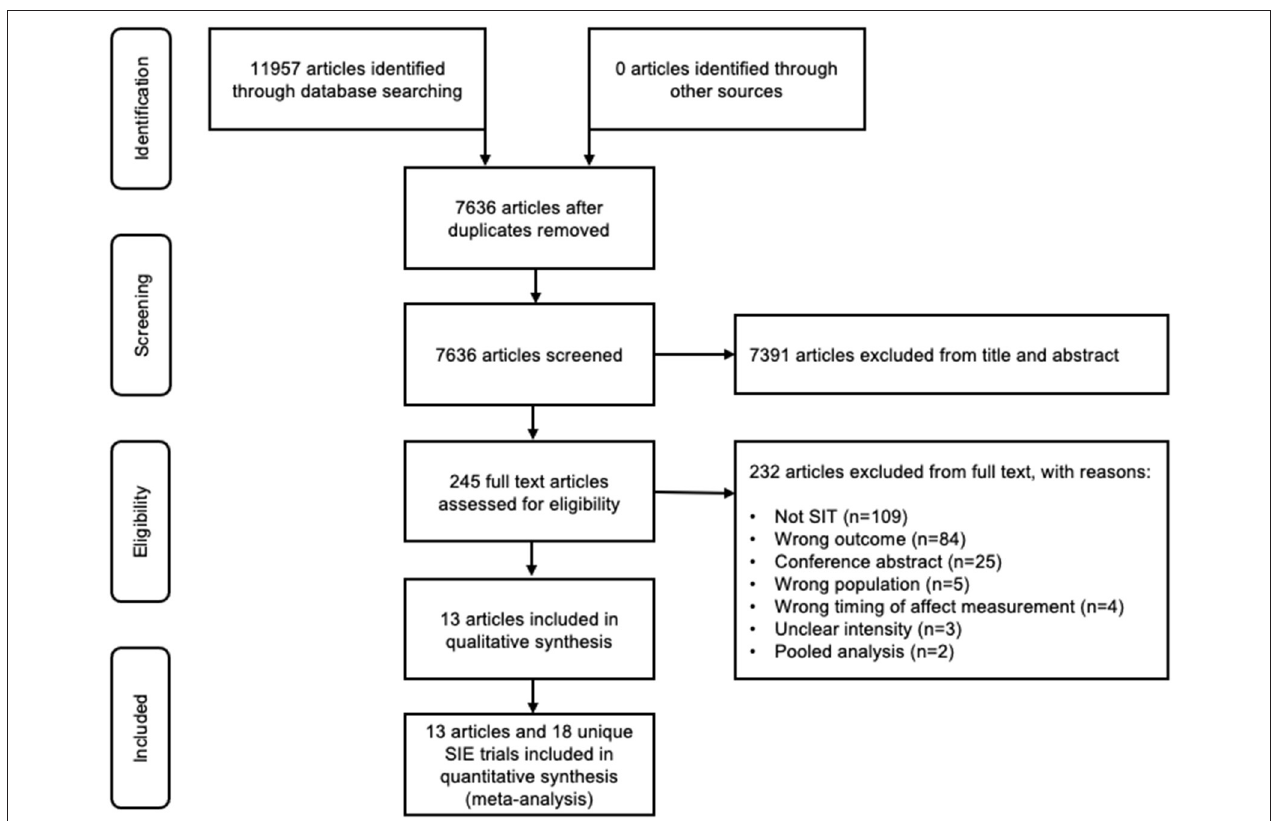
FIGURE 1 | PRISMA flow diagram of the study selection